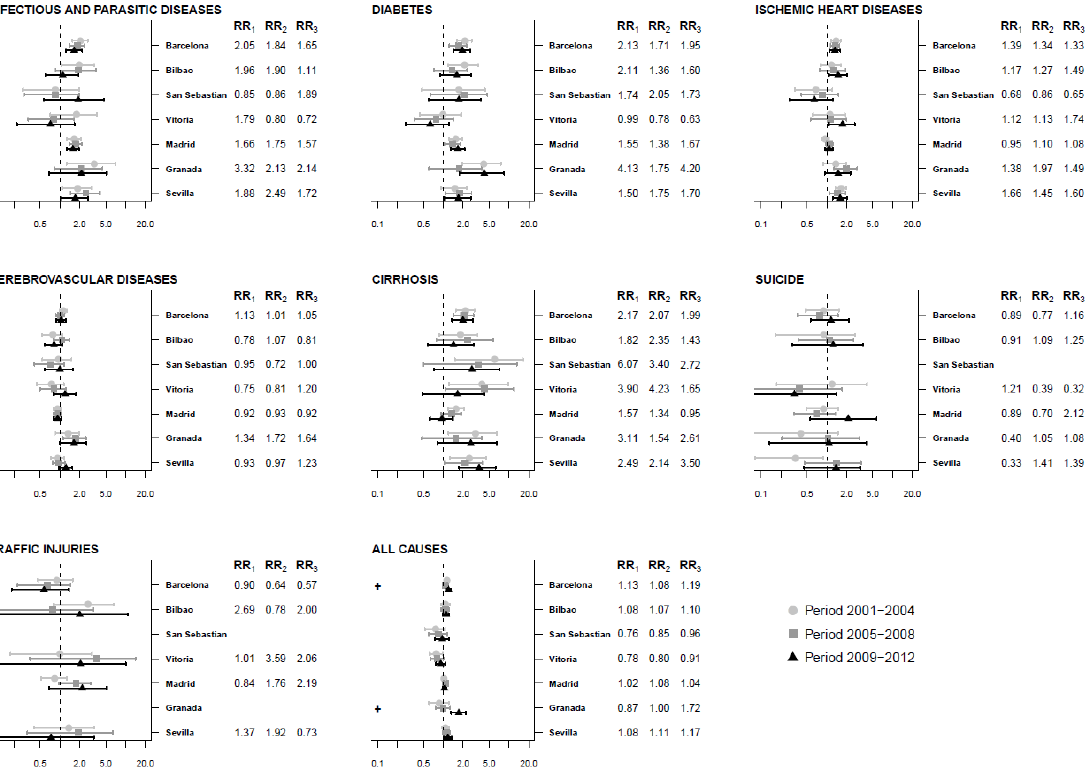
Figure 3. Association between the deprivation index and mortality. Relative risk comparing the 95th to 5th percentiles of the deprivation index by period and cause of death in seven Spanish cities for women, 2001–2012. Note: * indicates that RR 2 is statistically significantly different than RR 1 and + indicates that RR 3 is statistically significantly different than RR 2 . RR1: RR 2001–2004 period, RR2: RR 2005–2008 period, RR3: RR 2009–2012 period.